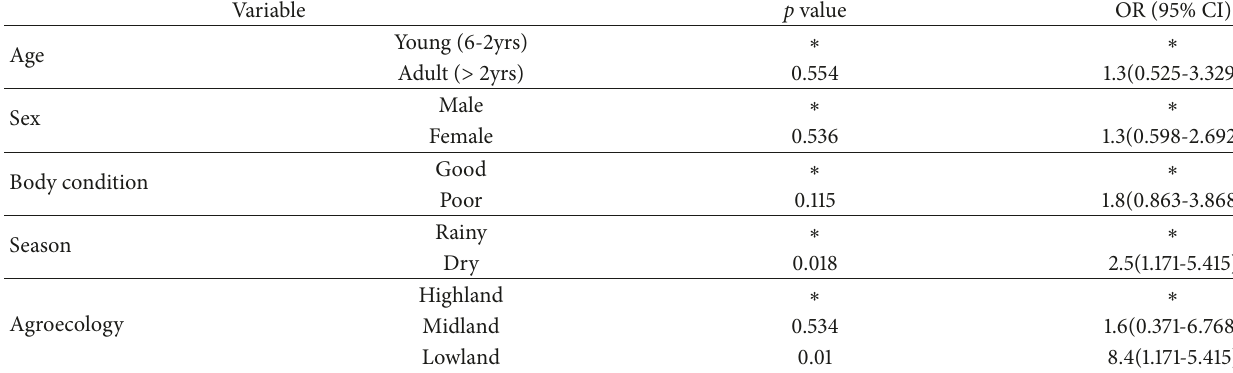
Table 3: Univariable logistic regression analysis of risk factors for seroprevalence of CBPP.